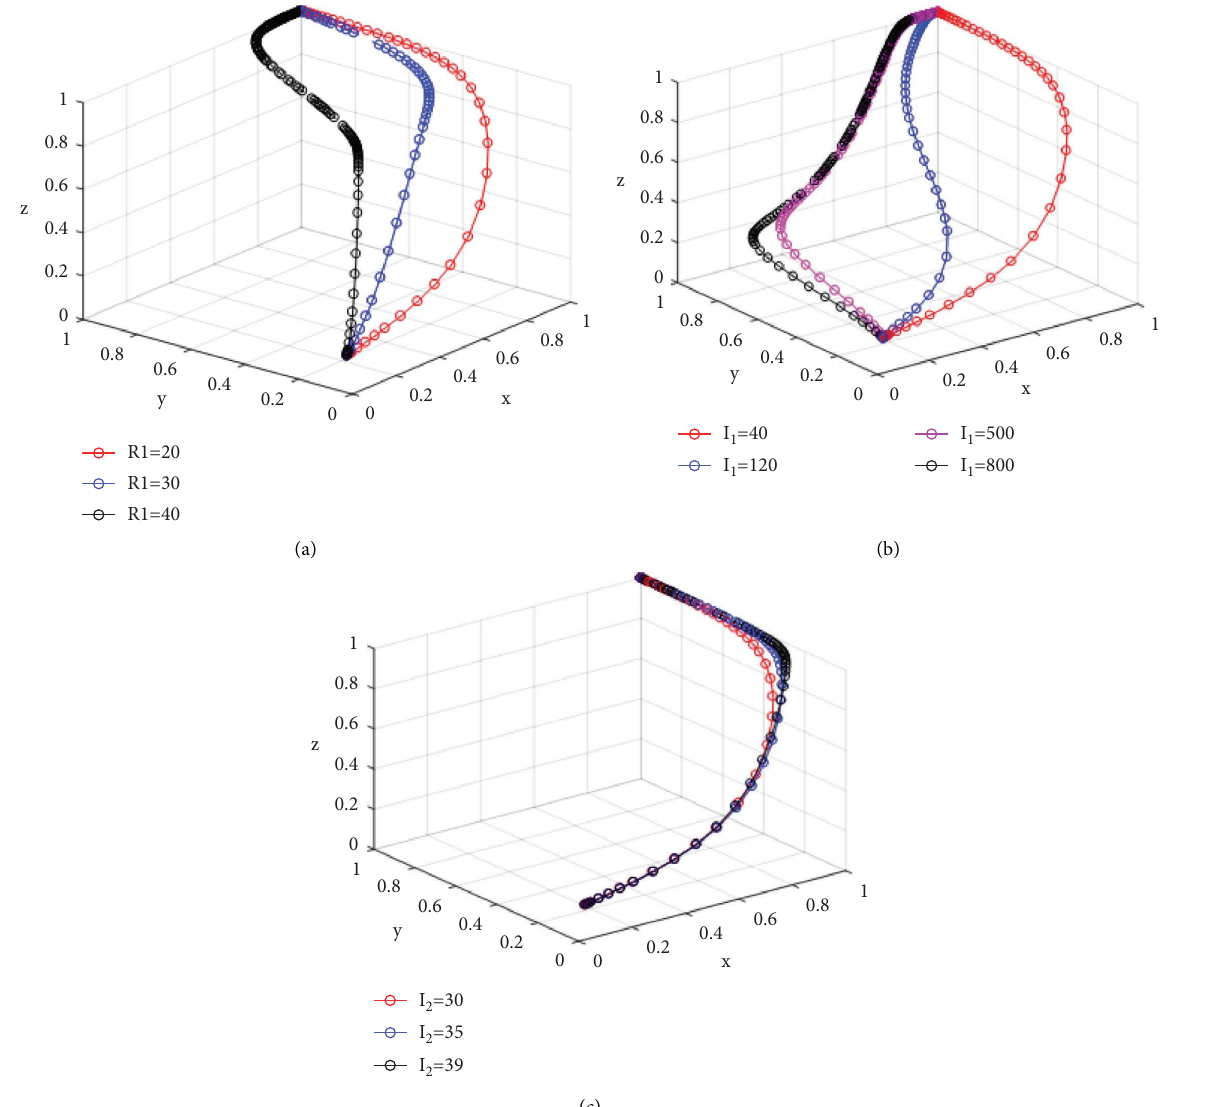
Figure 3: Efect of market factors on evolution results. (a) R refers to sales revenue generated by mariculturists adopting the ecological 1 aquaculture model; (b) I refers to the market sales income of aquatic enterprises and mariculturists adopting the ecological aquaculture 1 refers to the sales income of aquatic enterprises, when aquatic enterprises do not invest in ecological aquaculture and model; (c) I 2 mariculturists adopt the ecological aquaculture